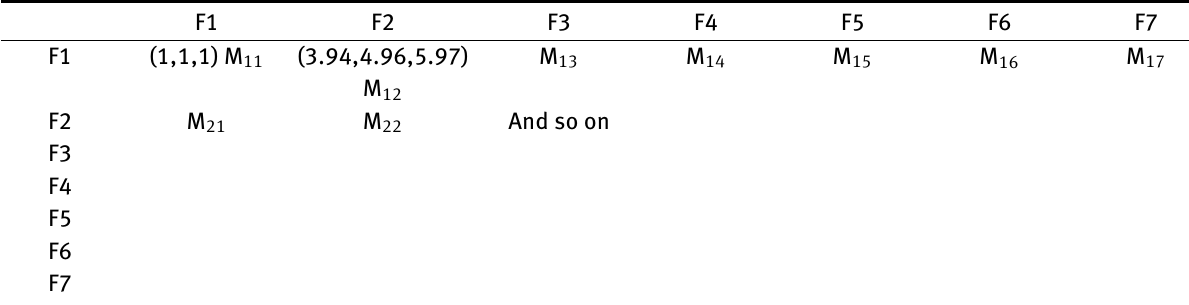
normalize it to get the final weight for the factors